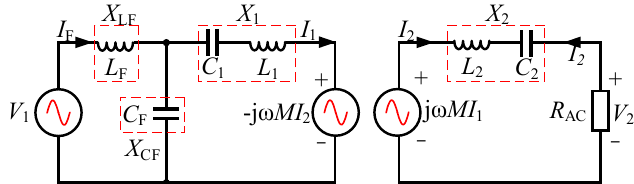
Figure 2. Equivalent circuit of the converter.